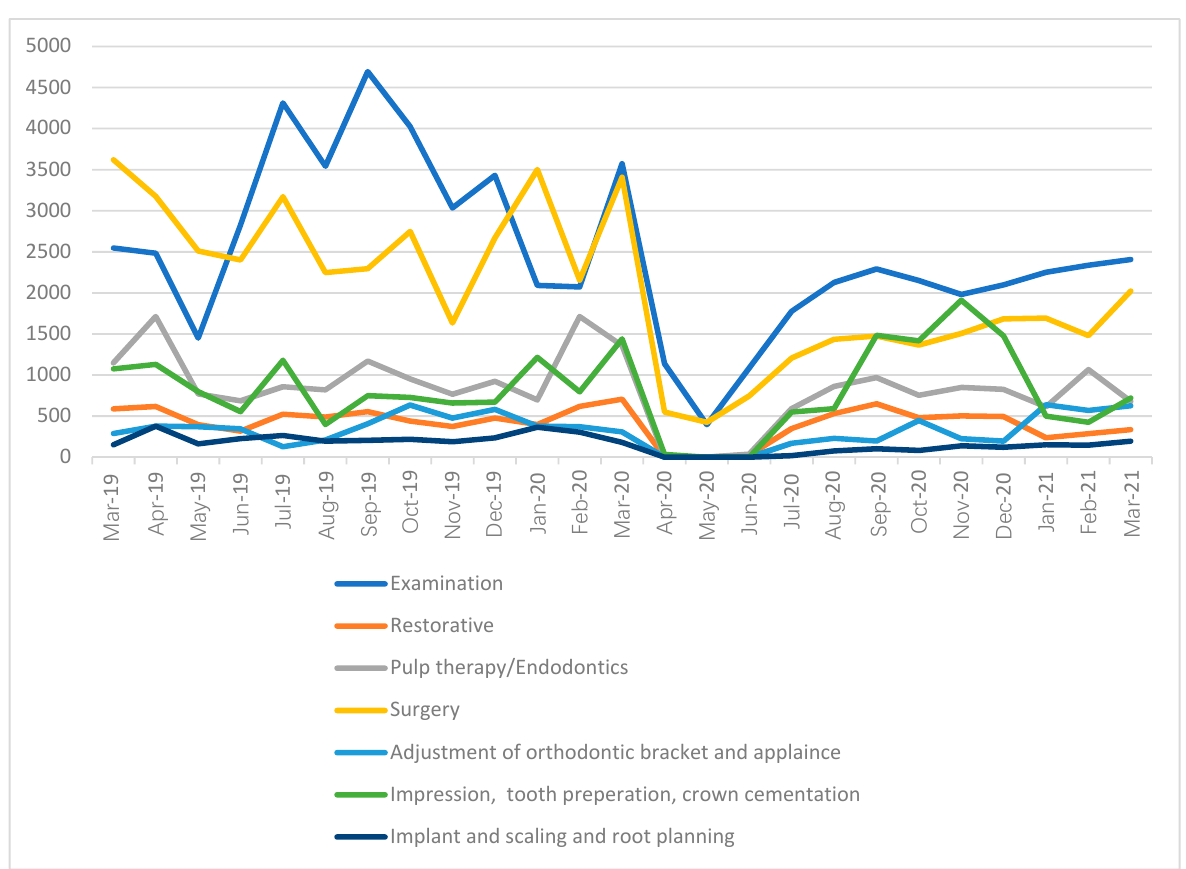
Figure 2. The number of treatments rendered before and during the pandemic, by type of treatment.